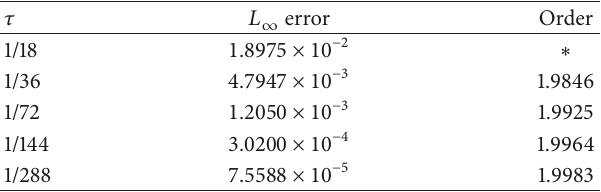
Table 2: Error and computational time orders of the scheme proposed in this paper with ℎ = 𝜋/160 and several values of 𝜏 for 𝑇 = 1 . 𝐿 ∞ error